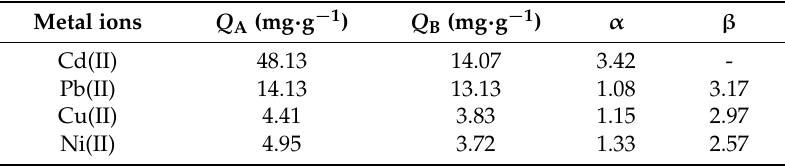
Table 1. Selectivity of MIIP towards different metal ions.